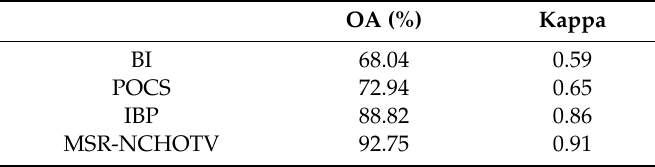
Table 4. Results of the overall accuracy (OA) and Kappa coe ffi cient of the four SRR methods. Table 3. Results of the overall accuracy (OA) and Kappa coefficient of the four SRR methods.